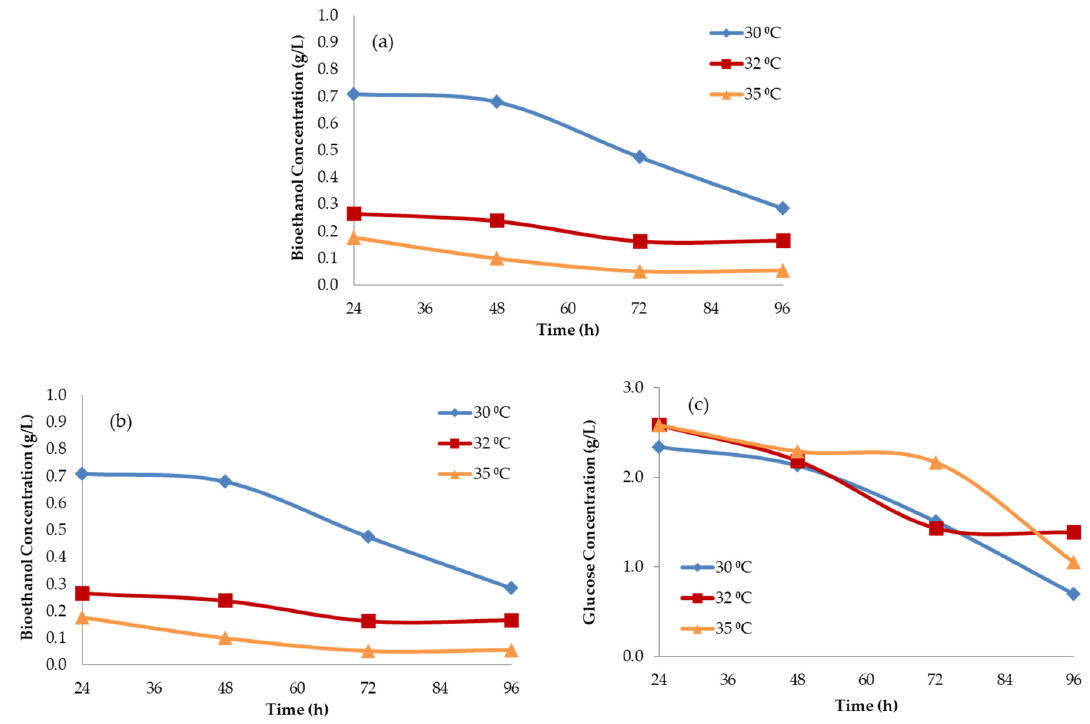
Figure 3. The concentration of bioethanol ( a ), yeast cell ( b ) and glucose ( c ) during SSF.